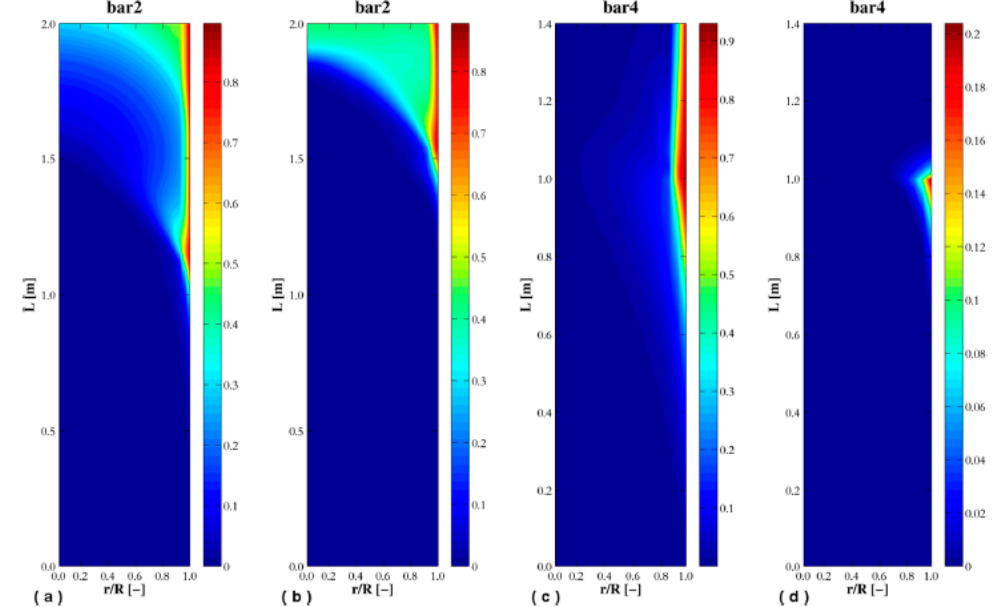
Figure 5. Volume fraction distribution predicted with computational fluid dynamics (CFD) simulation using RPI modelling of wall-boiling. Note the mismatch between the size of the simulation domains, more than one metre in length, and the likely much smaller characteristic size of the steam bubbles generated at the heated wall, of perhaps only 10–100 micron in diameter. The computational mesh used to resolve the volume fraction distribution indicated in the figure consists of cells much larger than the single bubbles, which are replaced by a corresponding continuous distribution of the vapour phase. The image shows results for two di ff erent benchmark cases [22] (‘bar2’ and ‘bar4’ in the figure), using in in the CFD model the bubble departure diameter correlations of Tolubinskiy et al. [23] (panels ( a , c ) and Kocamustafaogullari et al. [21] (panels ( b , d ). For the same test case, di ff erent correlations for computing the bubble departure diameter return radically discrepant volume fraction distributions. From Colombo et al. [4].